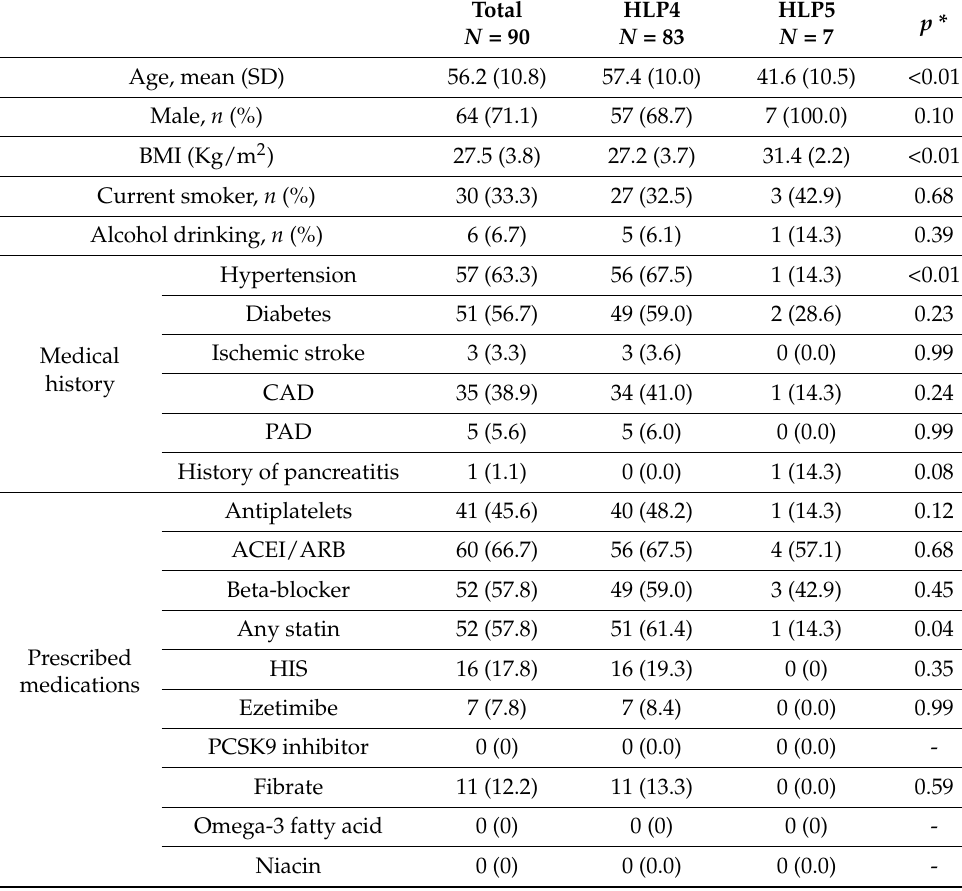
Table 1. Baseline characteristics of patients with HLP4 and patients with